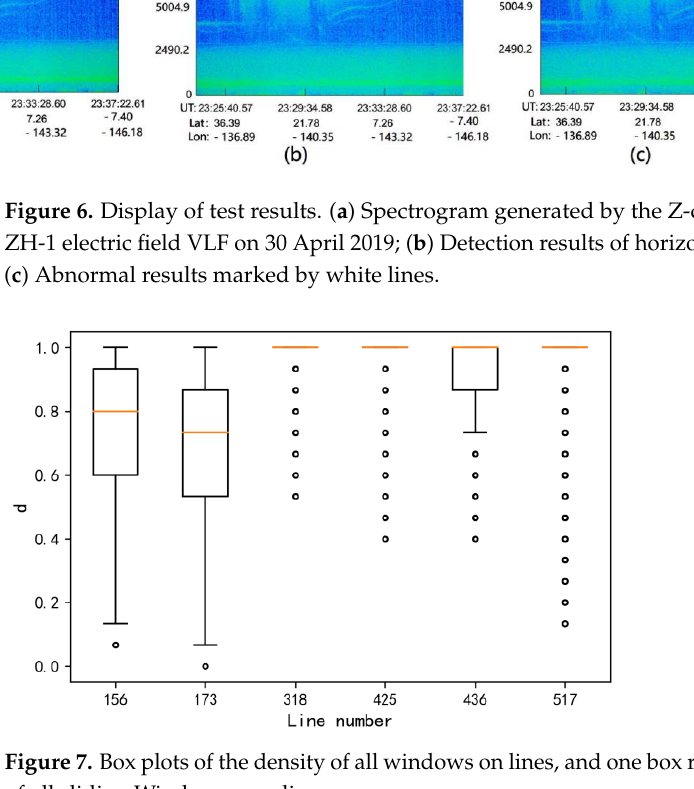
Figure 7. Box plots of the density of all windows on lines, and one box represents the density statistics of all sliding Windows on a